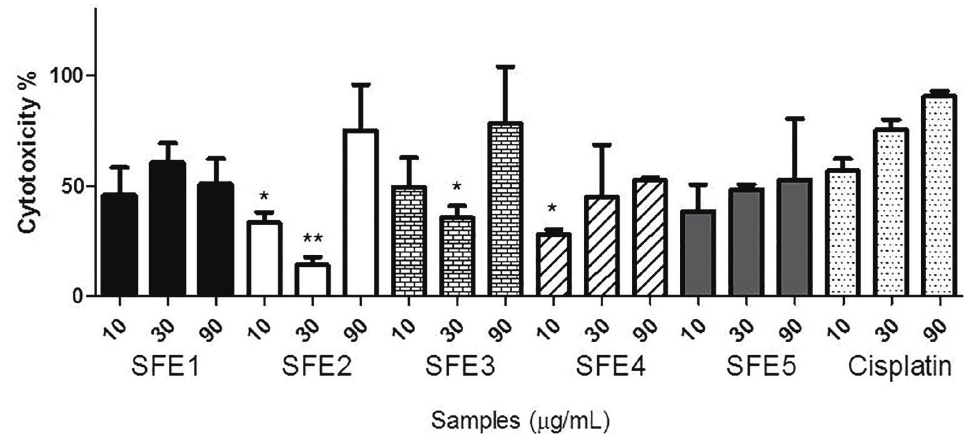
FIGURE 8 - Comparative analyses of the cytotoxic activity, in percentage values, for SFE1-SFE5, cisplatin against myeloid leukemia cells (K562), in three different concentrations (90, 30 and 10 μg.mL -1 ). The results express the average of three independent experiments in triplicate. The cells (10 6 .mL -1 ) was incubated only with culture medium (control C), or, with different concentrations of the samples by 48 h, at 37ºC, in humid atmosphere, with CO (5%). Statistical was performed by one-way ANOVA followed by 2 Tukey’s t-test (p<0.05). The analysis was comparative one by one with all concentrations to the major concentration of cisplatin (90 μg.mL -1 ). data obtained for the samples obtained from TABLE IV - IC 50 Passiflora mucronata leaves tested against K562 cell by